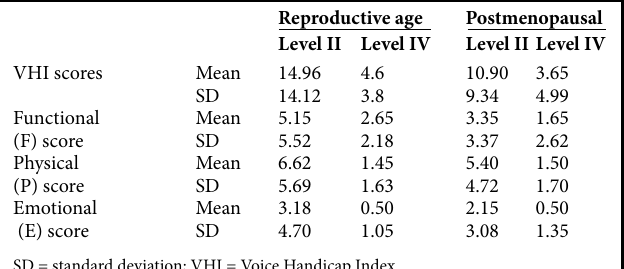
Table VII. Means and SDs of VHI total and subscale scores across the different groups